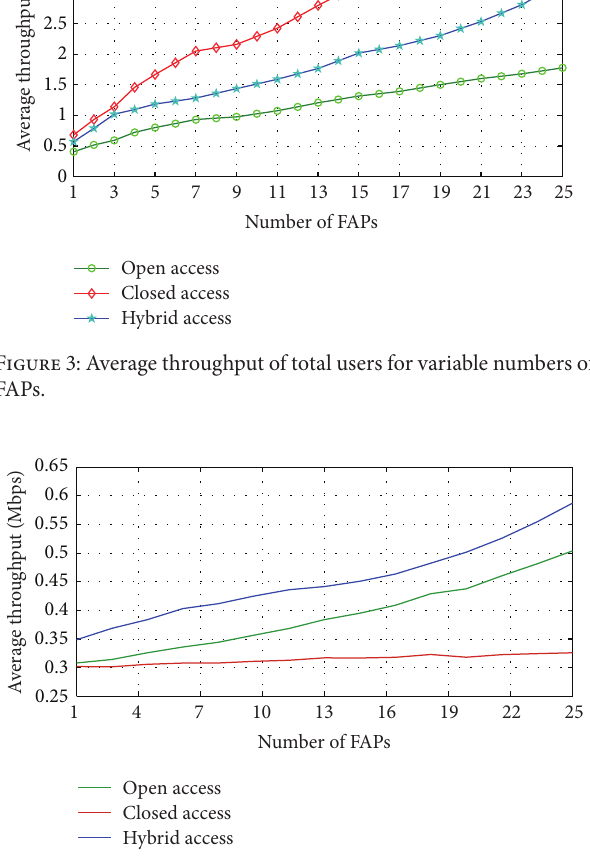
Figure 4: Average throughput of random users for variable number of